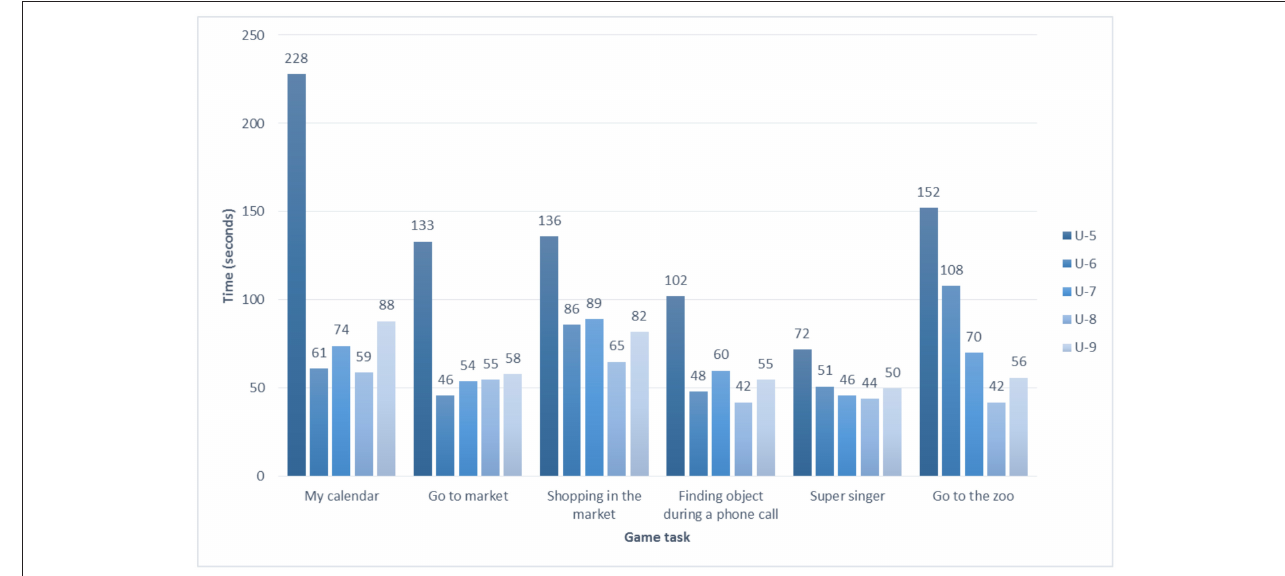
FIGURE 5 | Game task completion times per game and per user.